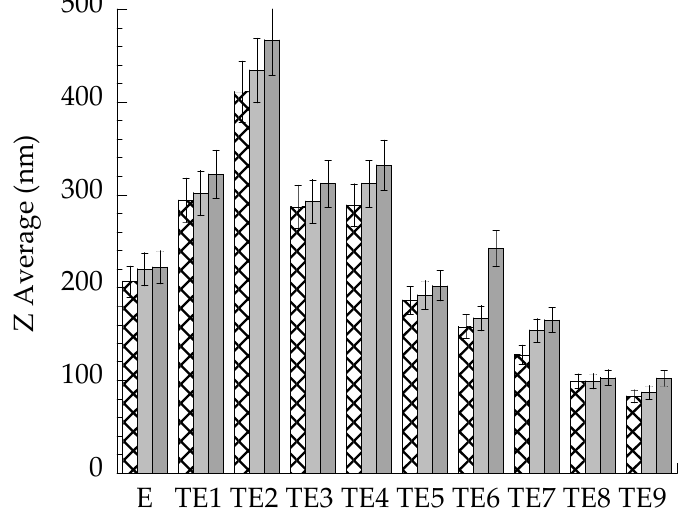
Figure 1. Effect of storage on vesicle mean diameter. E and TE were stored at 25 °C for 1 ( ), 2 ( ) and 3 ( ) months. Diameters were measured by PCS and expressed as Z average.